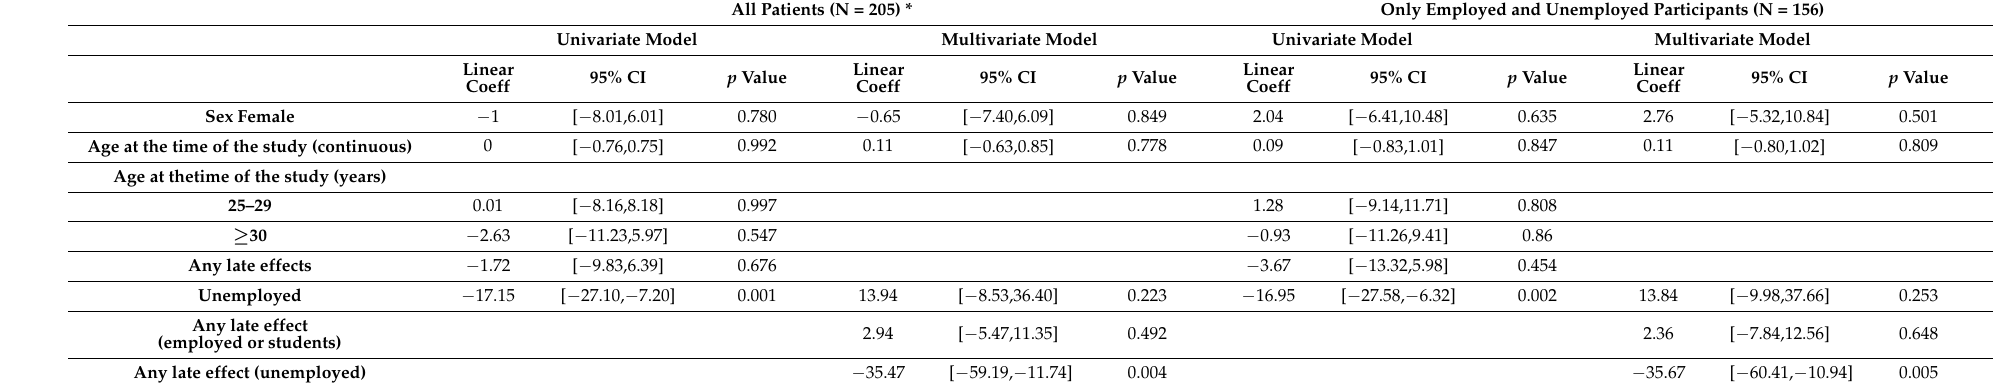
Table 4. Crude and adjusted effect on Work subscale of SAT-P.